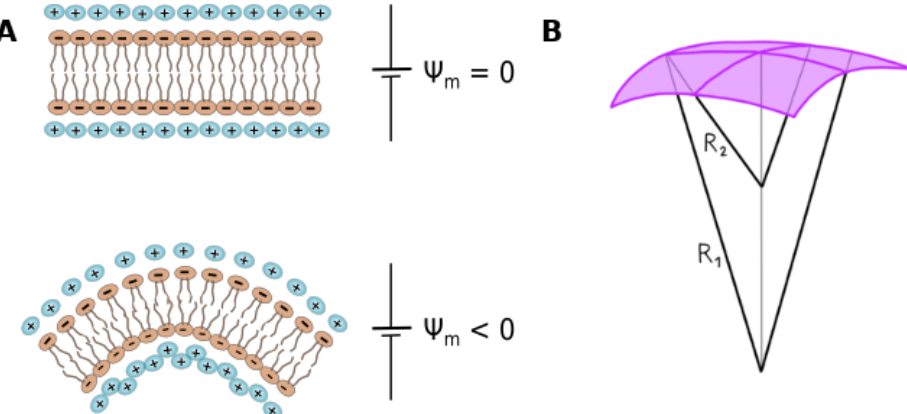
Figure 3. Flexoelectricity. ( A ) Scheme of flexoelectricity: Membrane is plane in the absence of a membrane electric field ( Ψ m = 0), while a curvature is induced due to the effect of the non-zero potential. ( B ) Scheme of curvature definition in a bidimensional plane, where R 1 and R 2 are the two main curvature